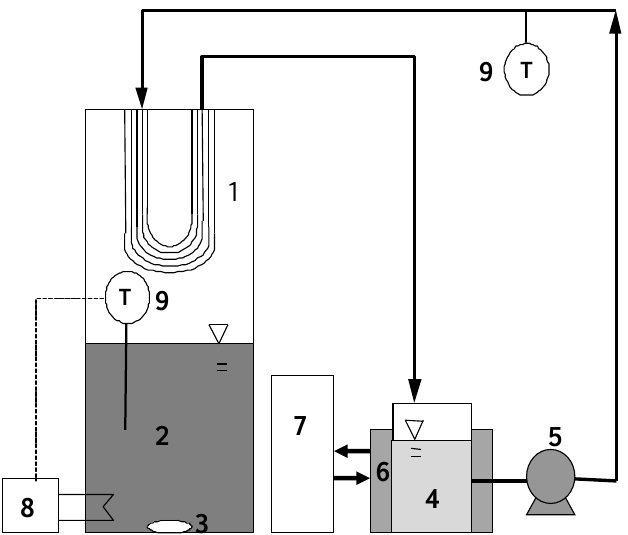
Figure 3. Schema of the modified MD apparatus employed (1: PTFE hollow fiber membrane; 2: feed solution ((NH 4 ) 2 SO 4 ); 3: magnetic stirrer; 4: ammonium hydroxide solution; 5: peristaltic pump; 6: ice water bath (10 °C); 7: chiller; 8: thermostatic bath (40 °C); 9: thermometers).